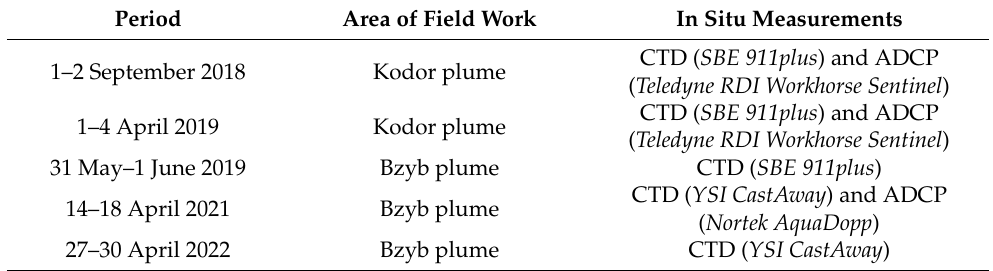
Table 1. Periods, areas of field work, and types of in situ measurements of oceanographic surveys.